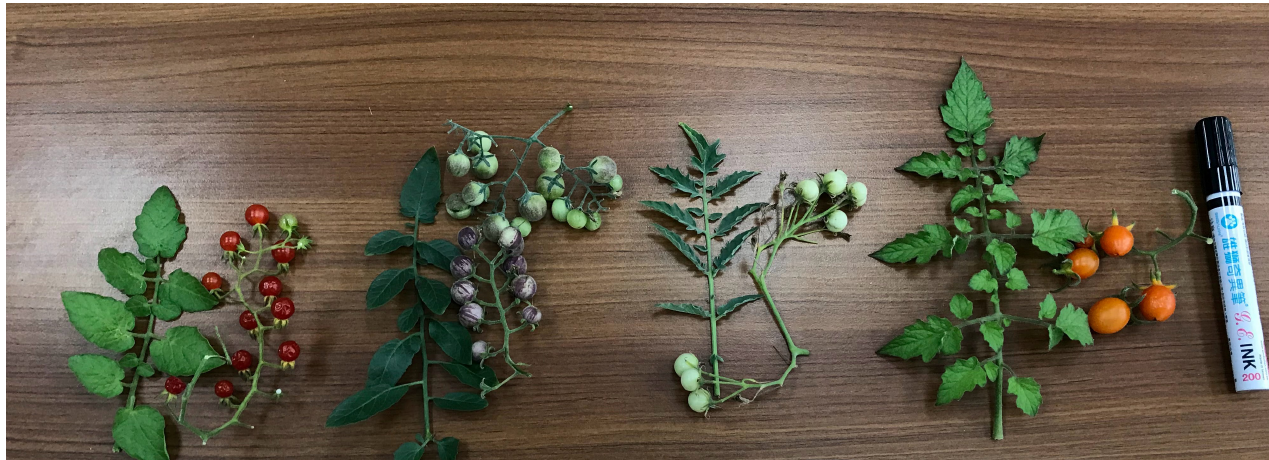
Figure 1. Diversity in fruit colour and leaf shape of some tomato wild relatives. From left to right: S. pimpinellifolium (LA1269), S. peruvianum (L00887-3), S. chilense (LA2737B) and S. galapagense (VI063177). The size of the marker is 14cm × 1cm. Photo credit: Hamid Khazaei Table 1. Genetic resources of tomato wild relatives maintained by the Tomato Genetics Resource Center (C.M. Rick TGRC), World Vegetable Center (WorldVeg), and the United States Department of Agriculture, Agricultural Research Service (USDA-ARS) genebanks (data accessed on June 23, 2022). Species No. of accessions per genebank